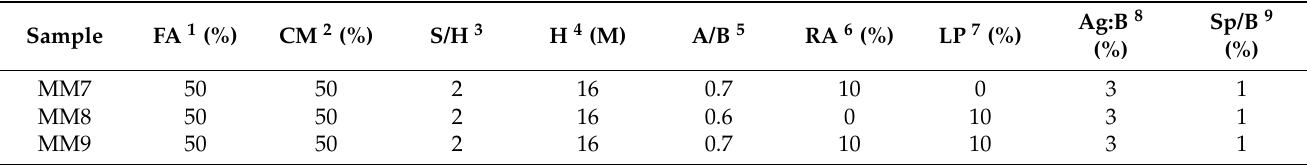
Table 5. Key material ratios of the third group of mortar mixtures.